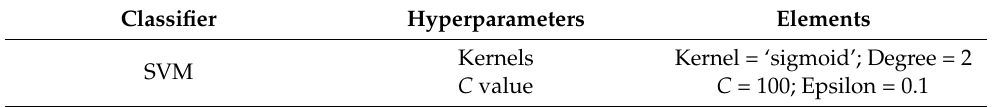
Table 1. The hyperparameters used in utilized models.